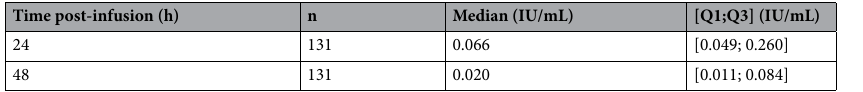
Time post-infusion (h)